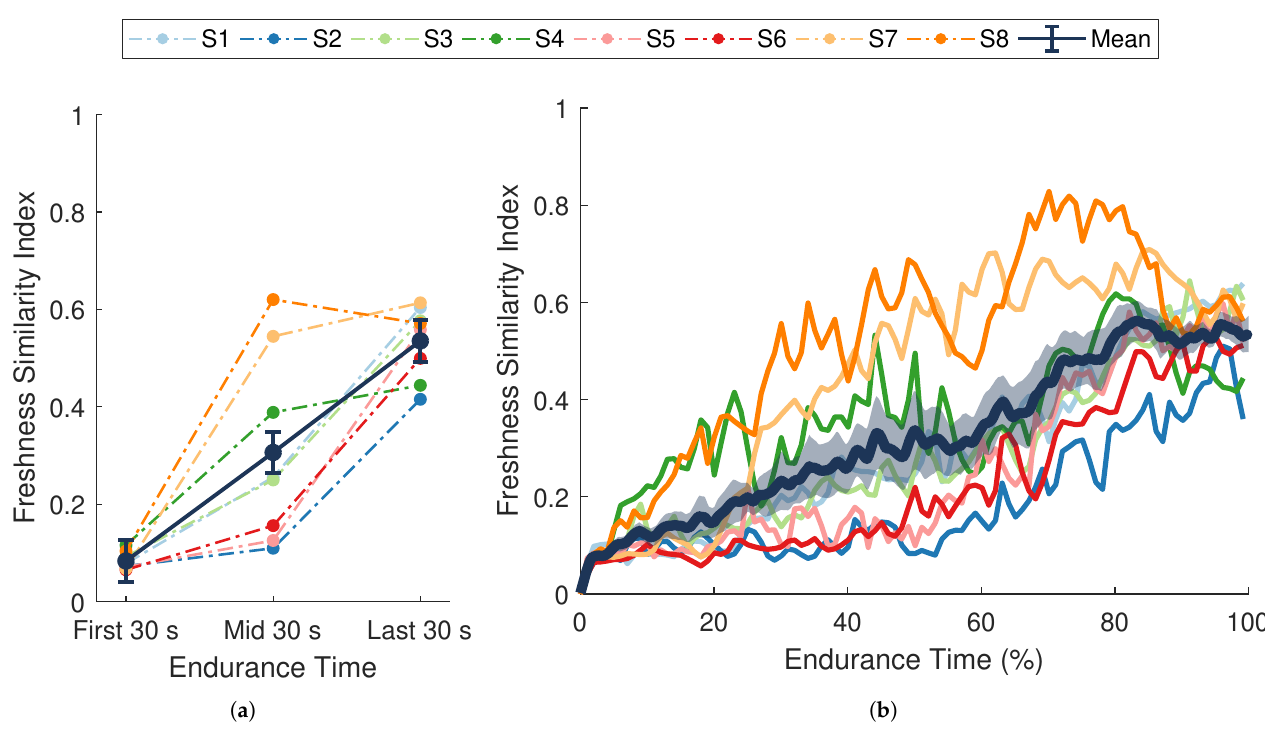
Figure 6. Freshness similarity index (FSI). ( a ) Dark blue data points separated by solid lines are means ± SE for the first, middle, and last 30 s of the task. ( b ) The dark blue line with shaded envelope represents the mean ± SE over each 1% of endurance time. Additional colored lines (dotted in ( a ), solid in ( b )) represent data from a single participant ( n = 8) whose assigned color is consistent across figures. FSI increased significantly over time ( p < 0.001, η 2 p =